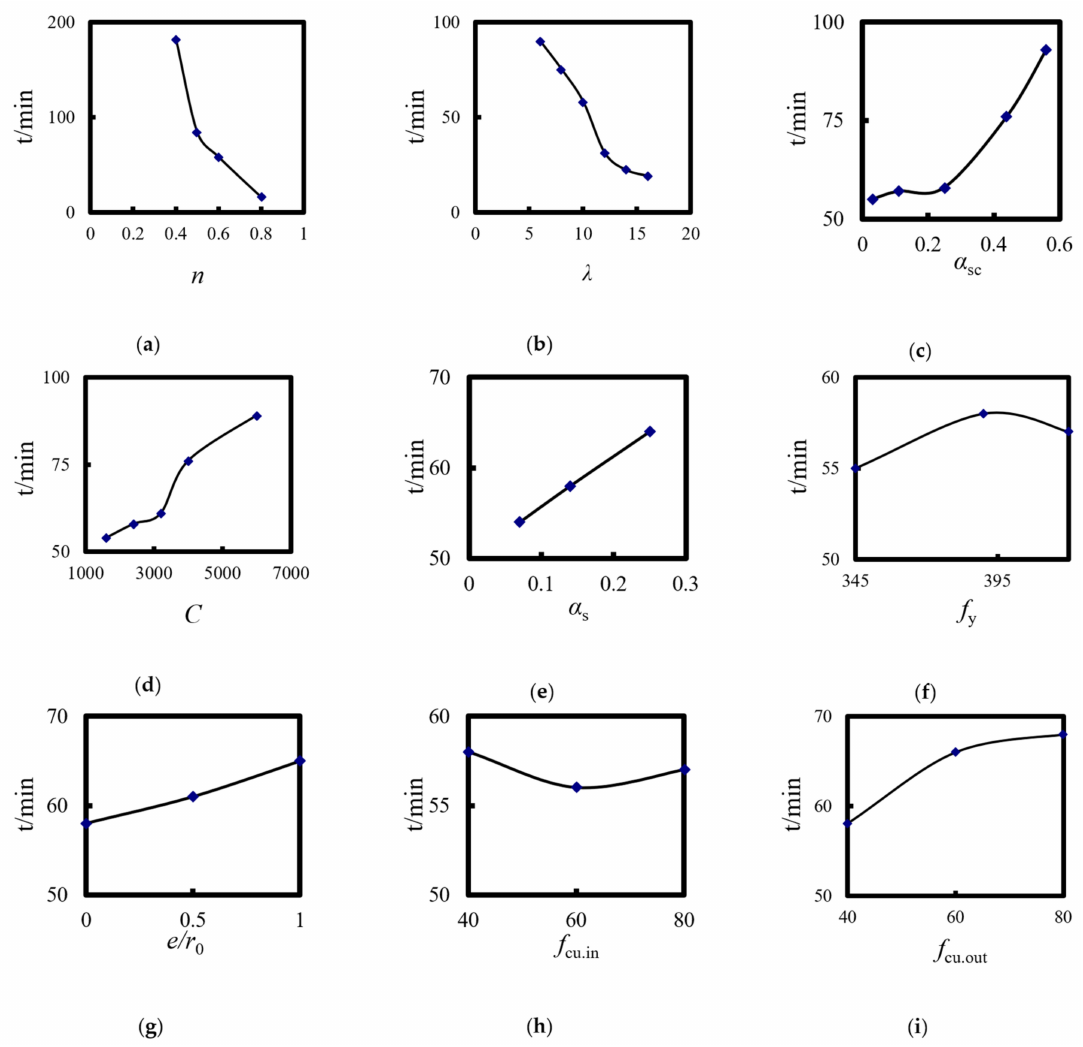
Figure 24. Effect of the parameters of the square-cased square ST-RC columns on the fire resistance limit ( a ) Load ratio; ( b ) Slenderness ratio; ( c ) Core area ratio; ( d ) Section perimeter; ( e ) Steel content; ( f ) Yield strength of steel pipe; ( g ) Load eccentricity; ( h ) Core concrete strength; ( i ) External concrete